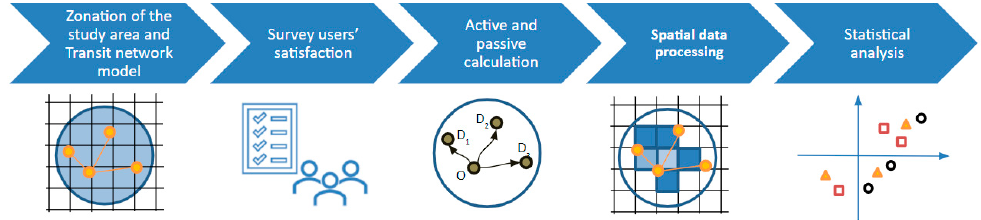
Figure 1. Methodology framework.